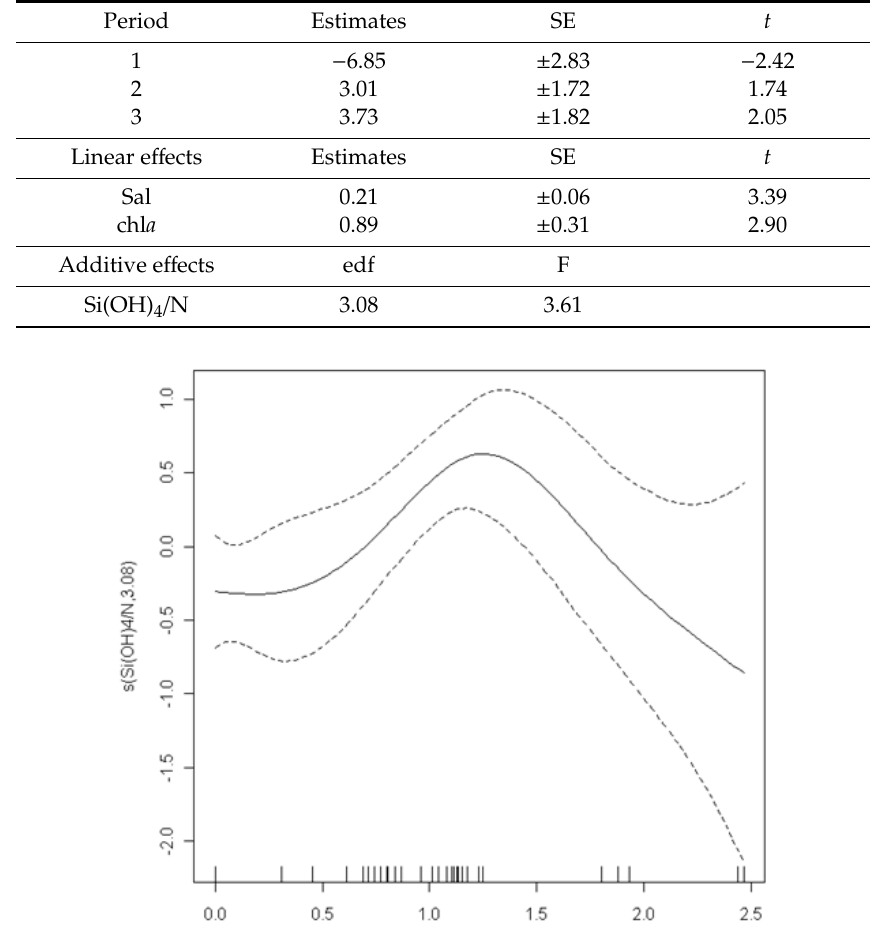
Table 5. Results of the generalised additive mixed models used to model the Pseudo-nitzschia spp. as a function of biotic and abiotic parameters. For linear covariates the parameter estimates with SE and t-values are given. For the additive covariate the estimated degrees of freedom (edf) and F-value are provided. Periods 1 (spring downwelling), 2 (summer), and 3 (autumn downwelling) corresponds to May, July, and October.